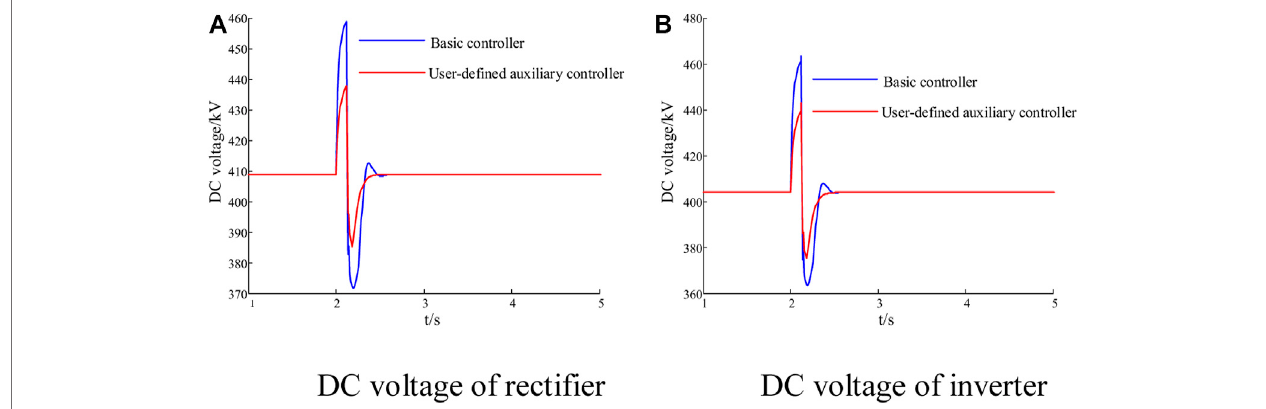
FIGURE 16 | Dynamic response of the MMC-HVDC system with two different controllers in PSS/E. (A) DC voltage of recti fi er (B) DC voltage of inverter.